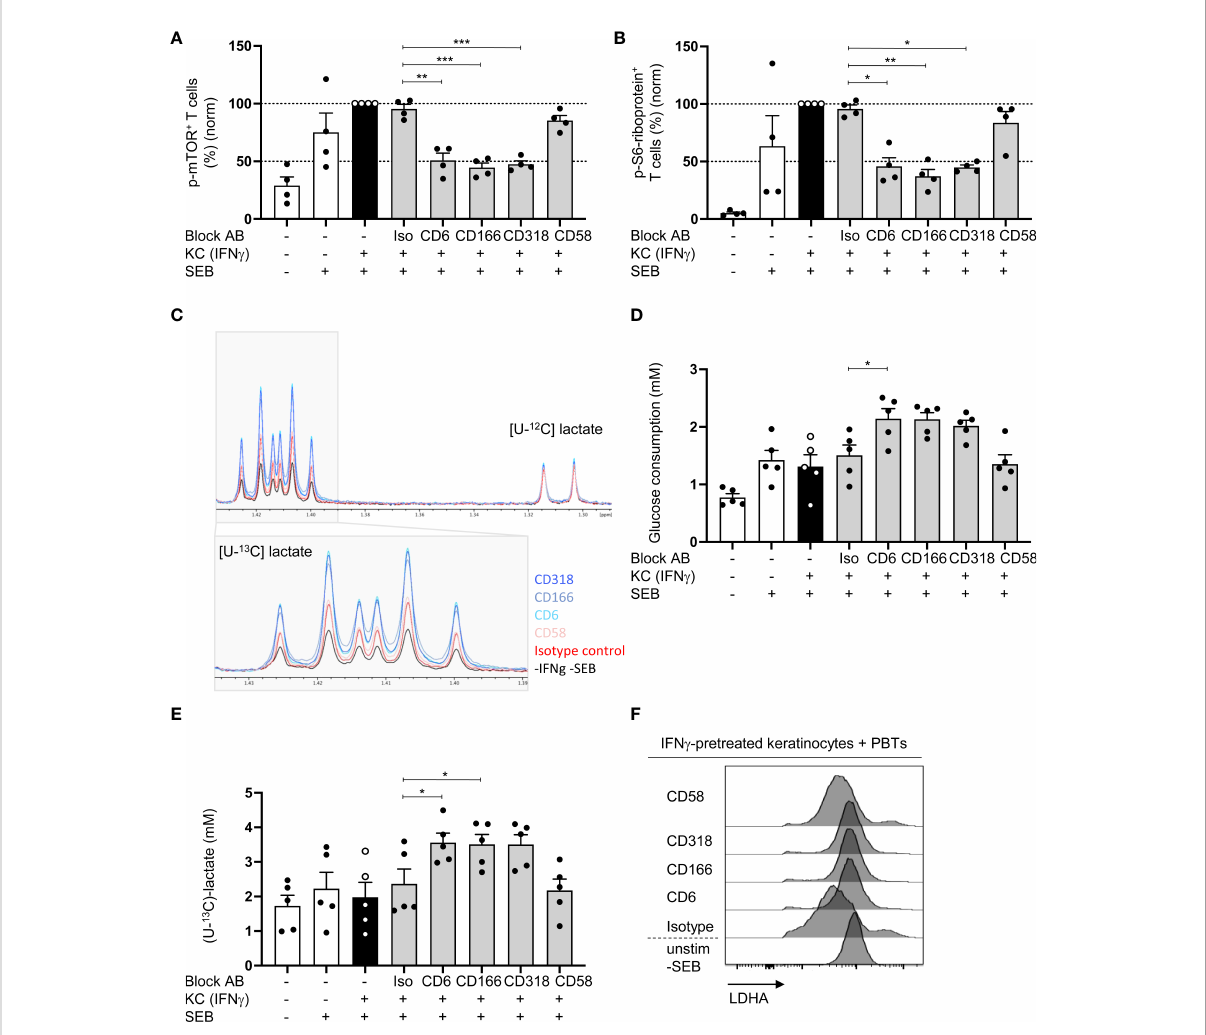
FIGURE 6 Blocking of CD6/CD166/CD318 interaction prevents mTOR activation and leads to increased aerobic glycolysis. CD3 + PBTs were cultured with untreated KCs (white bars) or IFN g -pretreated KCs (black and grey bars), loaded with SEB and the effects of blocking antibodies against CD6, CD166, CD318 or CD58, or isotype control antibodies (iso) were analyzed. (A, B) Flow cytometric analysis of mTOR activation after 72 h coculture. (A) Phosphorylation of mTOR at Ser2448, (B) phosphorylation of S6-riboprotein (n = 4 individual T cell donors). (C – E) Metabolism of isotopically labeled [U- 13 C]-glucose was analyzed in the supernatants of PBTs cultured for 72 h with fi xed untreated KCs (white bars) or IFN g - pretreated KCs (black and grey bars) by 1 H NMR. (C) Representative spectra of [U- 13 C]-lactate. (D) Statistical evaluation of glucose consumption and (E) concentration of [U- 13 C]-lactate (n = 5 individual T cell donors). Data was normalized to PBTs cultured with IFN g -pretreated KCs loaded with SEB (black bar). Data is represented as mean ± SEM. ***=p<0.001; **=p<0.01; *=p<0.05. (F) Flow cytometry of intracellular LDHA expression in PBTs cocultured for 72 h with untreated or IFN g -pretreated KCs either in the presence or absence of blocking antibodies against CD6, CD166, CD318 or CD58 or isotype control antibodies. Shown are representative histograms of one out of 6 independent